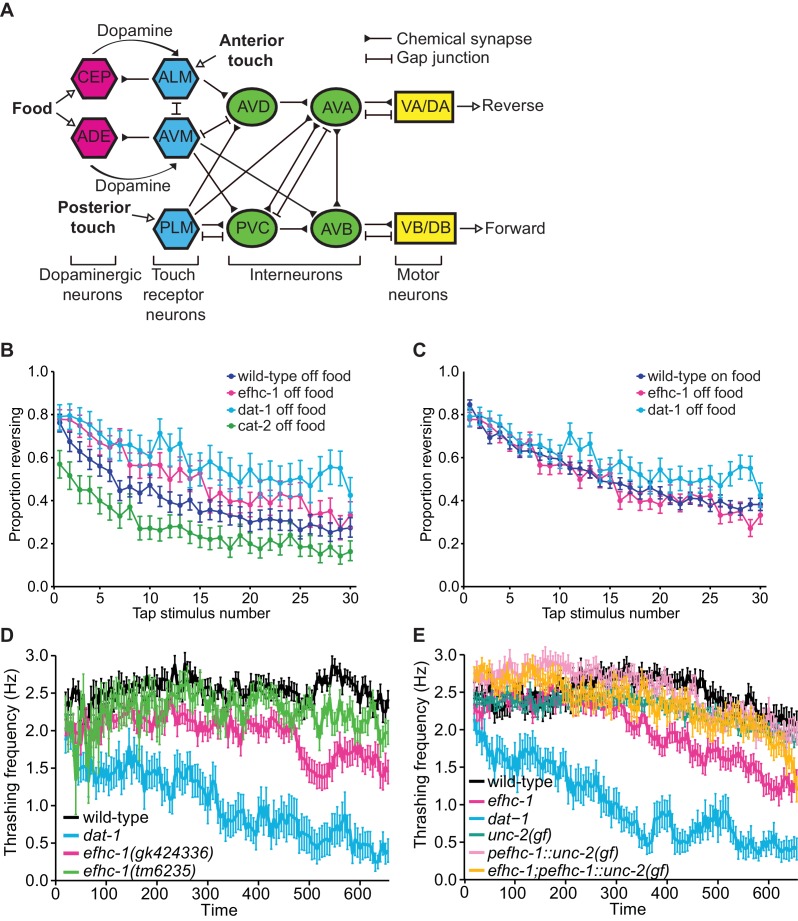
efhc-1 mutants show behavioral phenotypes consistent with increased dopamine signalling.(A) Neural circuit outlining how dopaminergic neurons influence touch receptor neuron activity (with some connections omitted for clarity). Food (bacteria) mechanically stimulates the dopaminergic CEP and ADE neurons to release dopamine. This dopamine acts extra-synaptically to modulate the sensitivity of the anterior touch receptor neurons (ALM and AVM) to touch. ALM and AVM neurons are activated by anterior touch (or tap) to promote backward movement, while the posterior touch receptor neuron PLM is activated by posterior touch to promote forward movement. This circuit is further fine-tuned by activation of CEP neurons by touch receptor neurons (not shown). (B) efhc-1 mutants show slower habituation compared to wild-type animals off food. At each tap, the points represent the number of worms reversing over the total number of worms tracked per strain, and the error bars represent the binomial confidence intervals. Binomial logistic regression followed by Tukey’s HSD (honest significant difference) test was used to determine significance of the habituated level (proportion reversing at tap 30) for each pair of strains. All strains are statistically different from each other (p < 0.001). (C) efhc-1 mutants off food mimic the habituation seen in wild-type animals on food. All strains are statistically different (p < 0.001) except for wild-type animals on food and efhc-1 mutants off food (p < 0.484). (D) An automated swimming-induced paralysis (SWIP) assay shows intermediate thrashing frequencies for the two efhc-1 alleles compared to dat-1 and wild-type animals. Each point represents the mean of thrashes counted over 5 s (divided by 5), and the error bars represent SEM. (E) efhc-1 mutants show an intermediate thrashing frequency compared to wild-type and dat-1 mutants. An unc-2(gain-of-function) mutation expressed throughout the animals, an unc-2(gain-of-function) mutation driven in EFHC-1-expressing cells, and efhc-1 mutants with the addition of the unc-2(gain-of-function) mutation driven in EFHC-1-expressing cells all show an increased thrashing frequency compared to efhc-1 animals but decreased compared to wild-type animals. For sample sizes (n) for tap habituation experiments and complete statistical comparisons (p values) see Supplementary files 1 and 2, respectively.